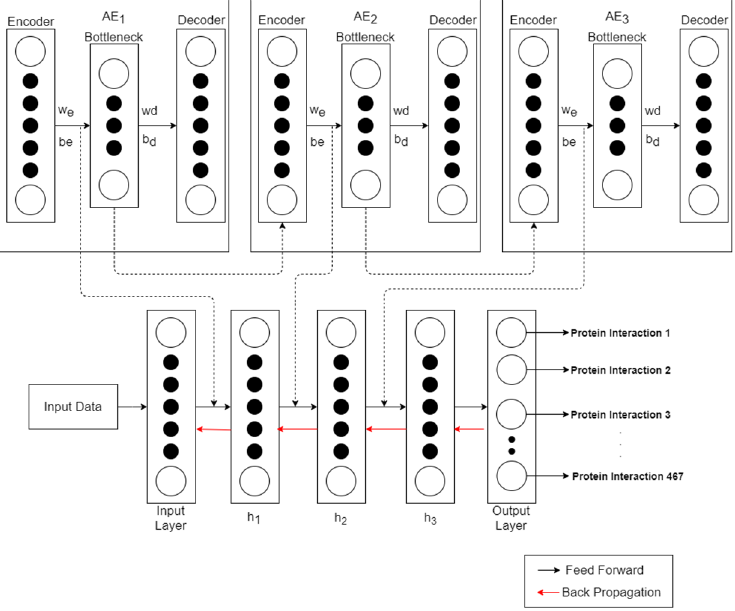
Figure 4. SAE-DNN architecture.